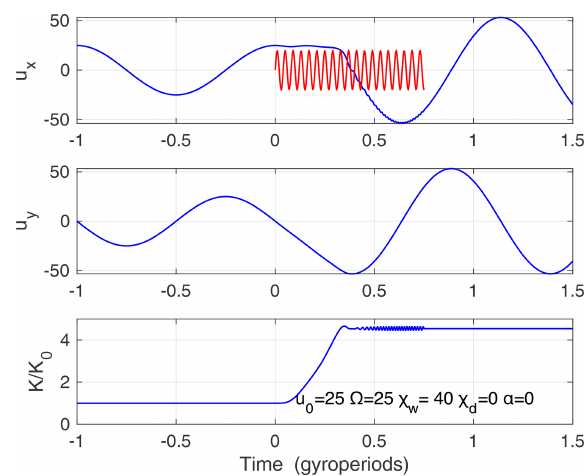
Figure 5. Exact solutions of Eqs. (5)–(9) with a numerical accuracy of 10 − 6 . A proton with normalised gyration speed u 0 = 25 is drift- ing earthward with convection speed u x = χ d = 5. At time t = 0 it encounters a burst of waves with frequency f = 25 f cp propagating upstream, α = 180 ◦ , active during time 0 . 4 f − 1 cp . The particle is ac- celerated by more than 4 times the initial gyration energy as shown in the lower panel. Acceleration increases u y while u x remains con- stant, which corresponds to the situation seen in Fig. 4, column E, row 1.